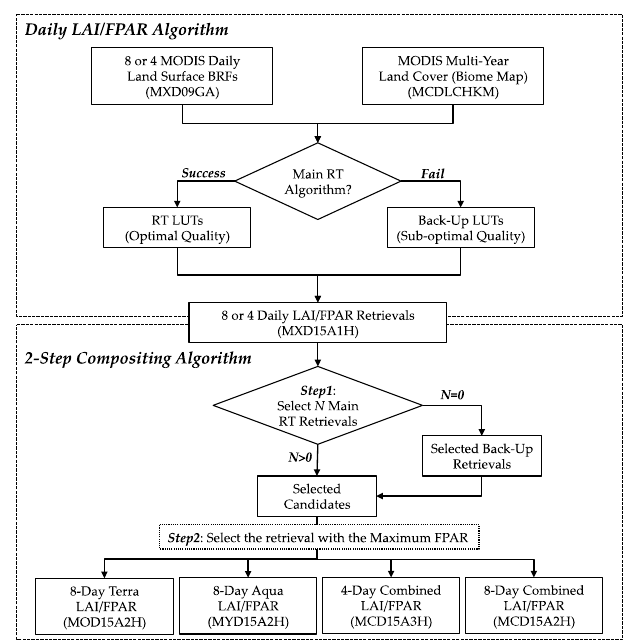
Figure 1. Algorithm flow of MODIS LAI/FPAR Collection 6 production. Four different global products with different compositing (8-day or 4-day) periods and sensor platform combinations (Terra and/or Aqua) are available.